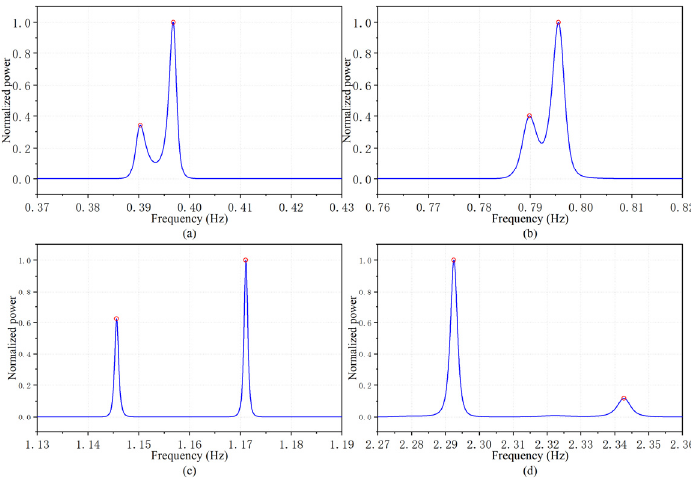
Figure 7. The results obtained by SFFT-IAA (SRN = 10). The red circles indicate estimated frequencies. ( a ) Frequency band [0.37 Hz 0.43 Hz]; ( b ) Frequency band [0.76 Hz 0.82 Hz]; ( c ) Frequency band [1.12 Hz 1.19 Hz]; ( d ) Frequency band [2.27 Hz 2.36 Hz].